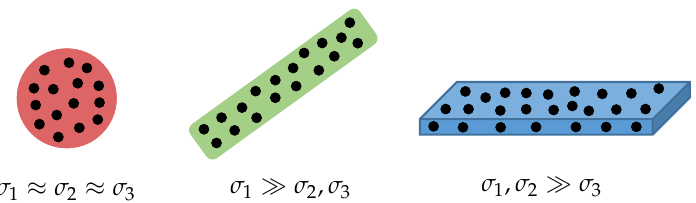
√ λ i represent the